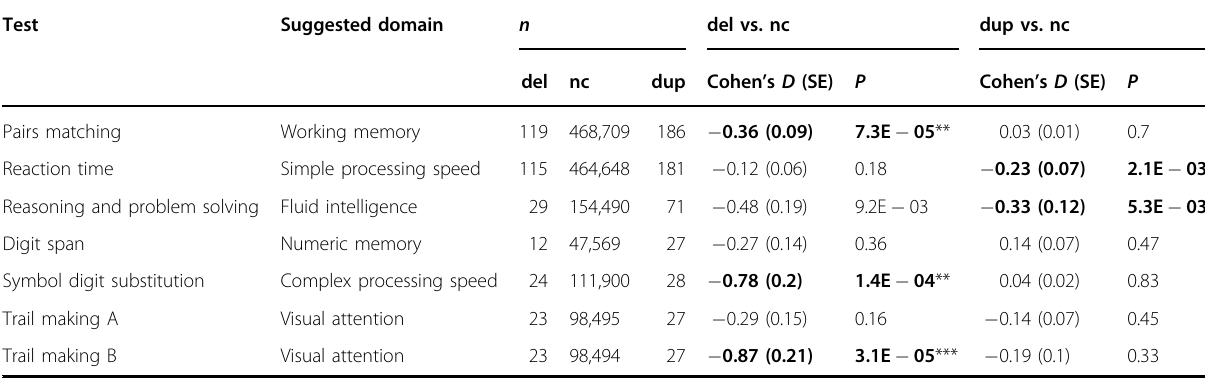
Table 2 1q21.1 CNV deletion and duplication carriers show de fi cits in speci fi c cognitive